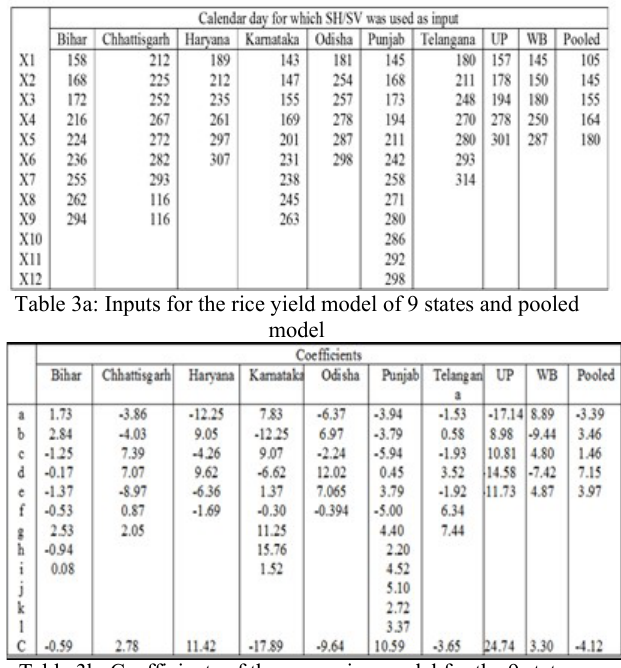
Table 3b: Coefficients of the regression model for the 9